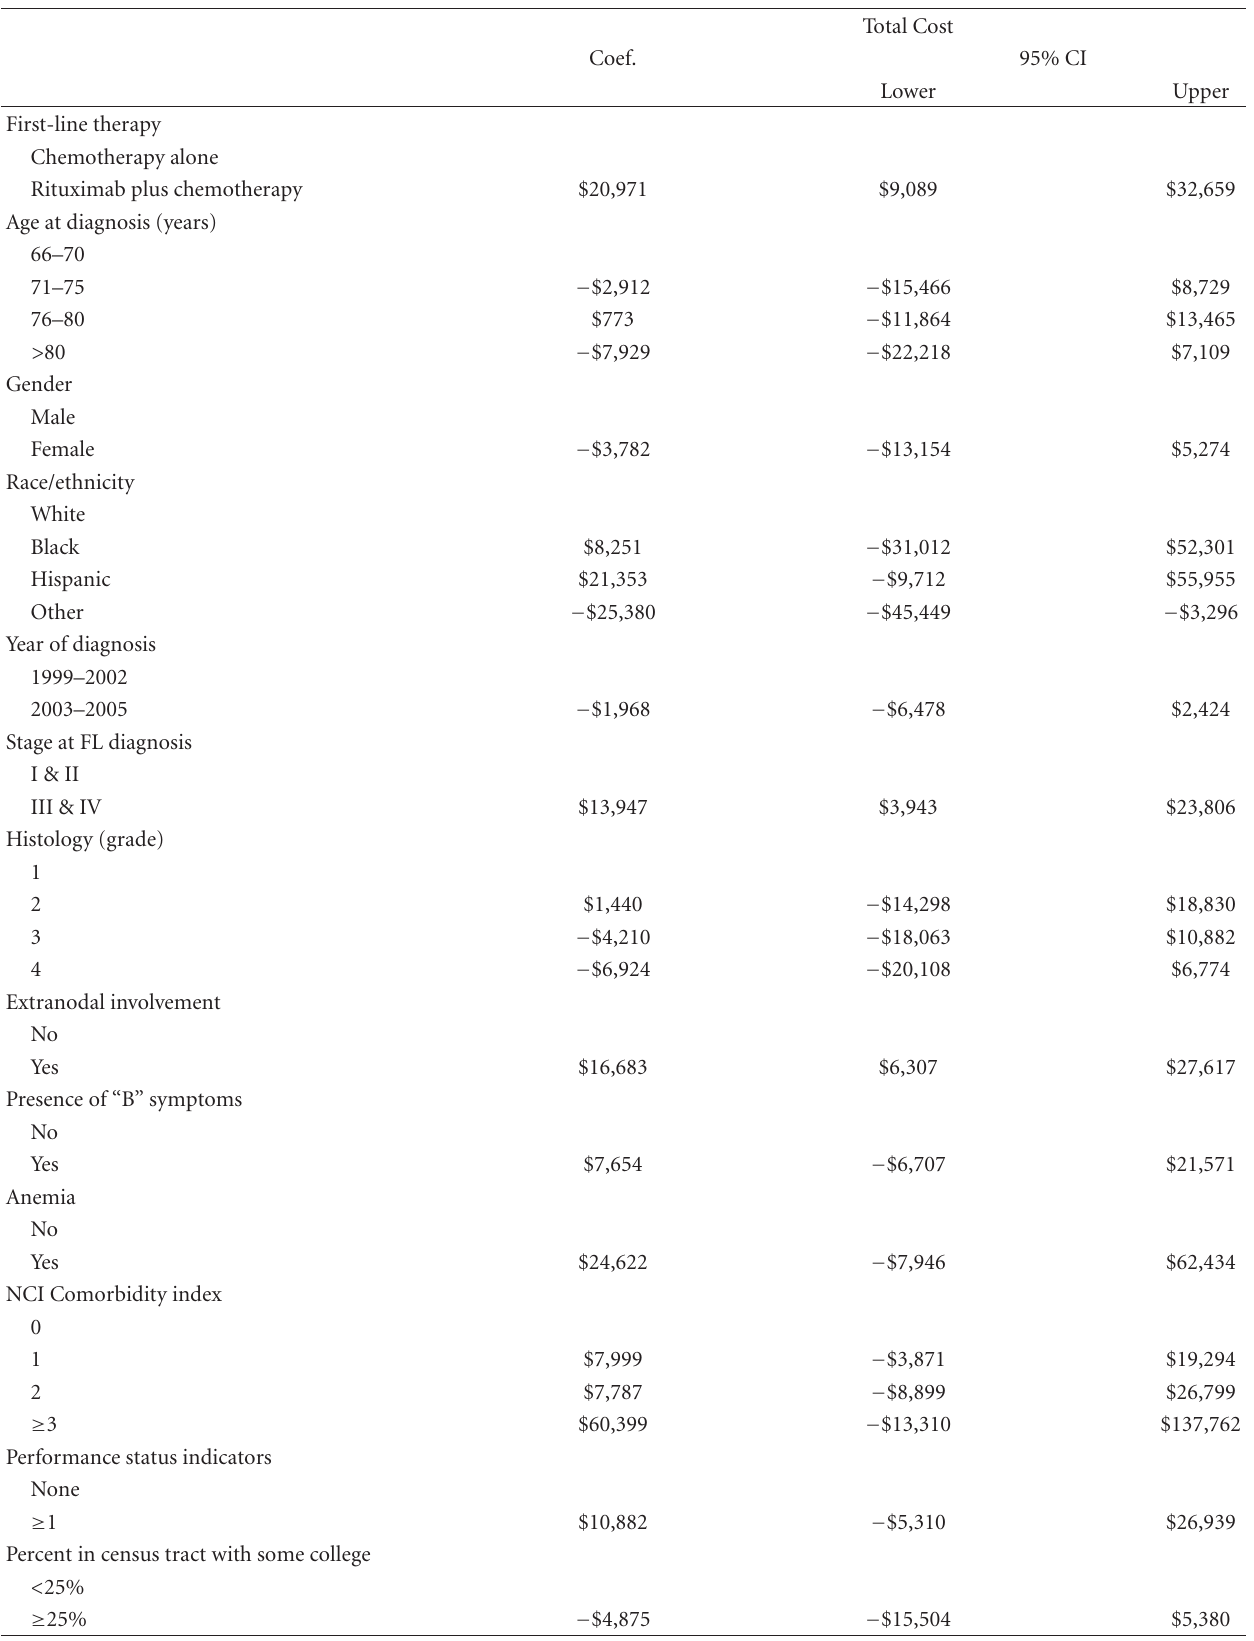
Table 3: Multivariate analysis—CHOP patients